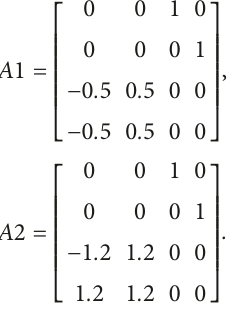
Figure 7: State and estimated state with δ � 0 .